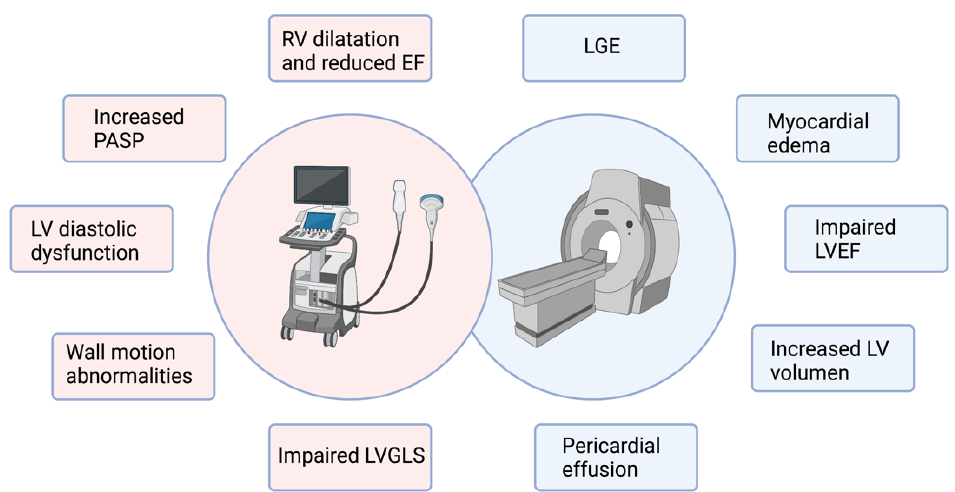
Figure 3. Cardiac imaging techniques main findings in COVID-19 patients with cardiac involvement. On the left, echocardiography findings are summarized. On the right, CMR findings. CMR, cardiac magnetic resonance; LGE, late gadolinium enhancement; LV, left ventricle; LVGLS, left ventricle global longitudinal strain; PASP, pulmonary artery systolic pressure; RV, right ventricle; TAPSE, anterior tricuspid plane systolic excursion.